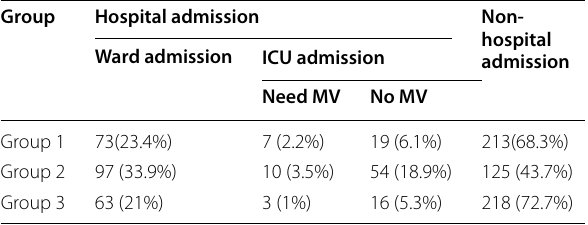
Table 3 Patients place of management Group